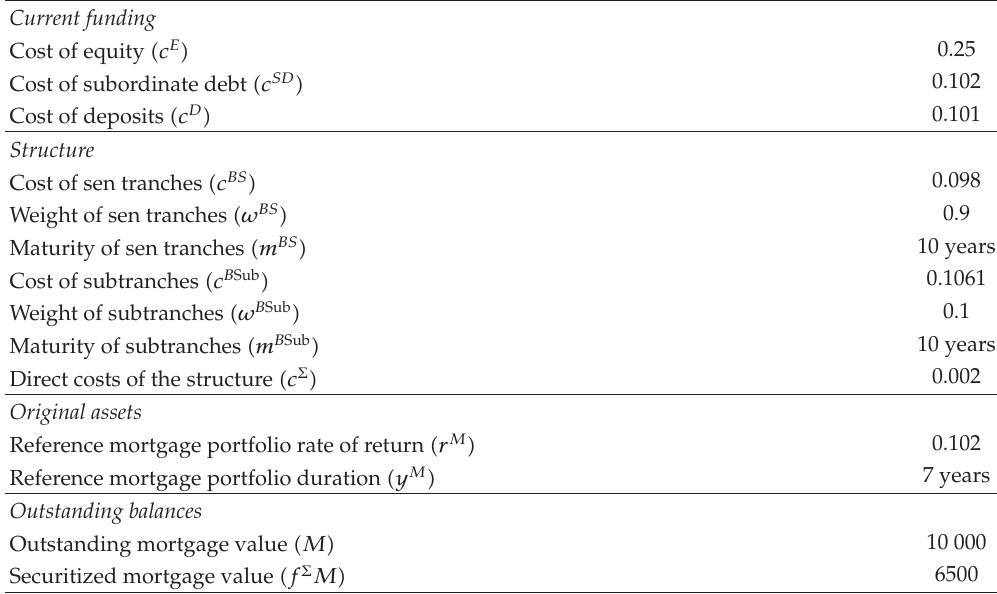
Table 4: Original mortgage portfolio.